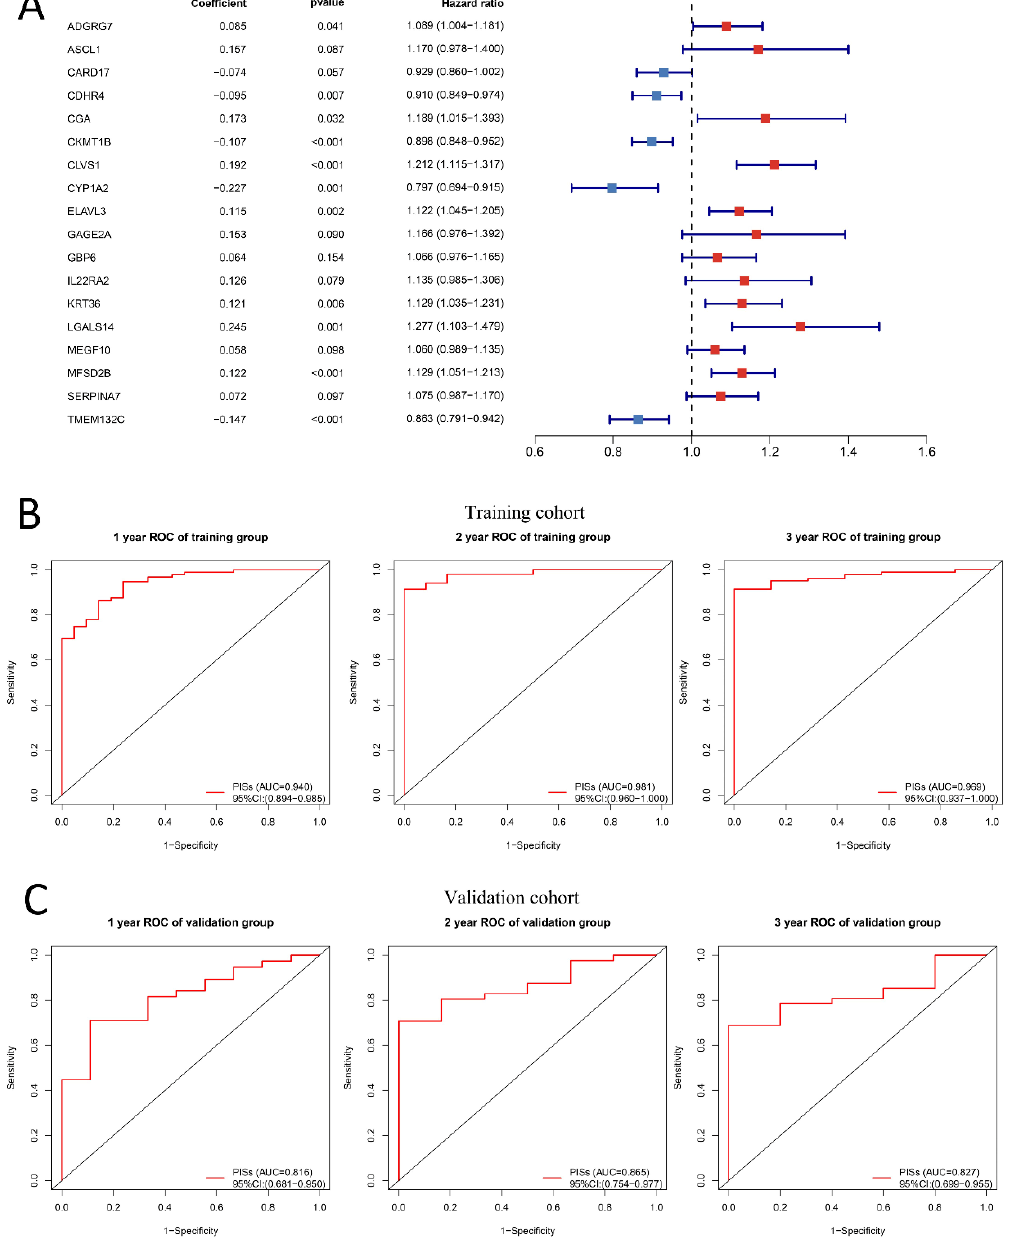
Figure 7. Robustness evaluation of prognostic immune signature (PIS) in predicting progression-free survival. ( A ): 18 genes constituting PIS and their corresponding risk coefficient, p value, and hazard ratio. The sum of the expression level of each gene multiplied by its corresponding coefficient is the PIS score. The forest plot on the right visualizes the hazard ratio of the marker. If the hazard ratio of a gene is less than 1, it is indicated in blue, otherwise, it is indicated in red. In addition, the line length represents the 95% confidence interval of the hazard ratio. ( B , C ): The AUC of 1-, 2- and 3-year progression-free survival in the training cohort and validation cohort. The 1-, 2- and 3-year AUC for PFS was 0.940 (95% CI: 0.894 − 0.985), 0.981 (95% CI: 0.960 − 1.000), and 0.969 (95% CI: 0.937 − 1.000) in the training cohort, respectively. With 1-, 2- and 3-year AUCs of 0.816 (95% CI: 0.681 − 0.950), 0.865 (95% CI: 0.754 − 0.977), and 0.827 (95% CI: 0.699 − 0.955) in the validation set, respectively.